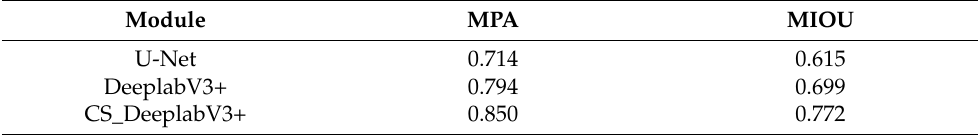
Table 2. Performance comparison of different semantic segmentation